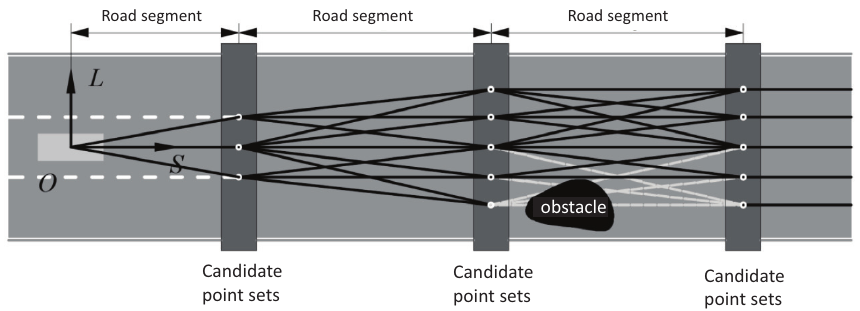
Figure 4. The diagram of Generation of Candidate